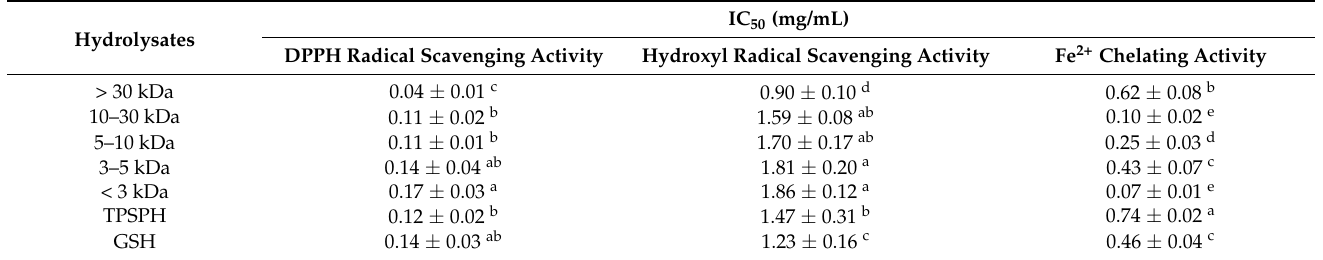
Different letters in the same column indicate significant difference ( p < 0.05). Results are expressed as the mean ± standard deviation ( n =